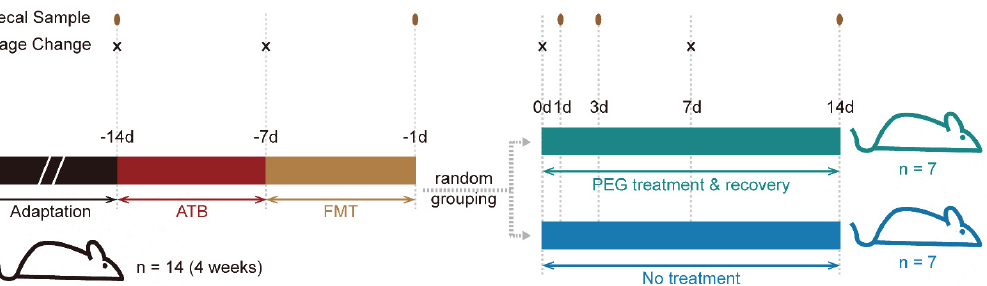
Figure 2. Schematic of animal experimental design and collection protocol. The adaptation period of mice is one week; ATB, gavage with antibiotics; FMT, fecal microbiota transplantation from healthy donor to mice; PEG treatment, gavage polyethylene glycol electrolyte solution for bowel cleansing. The times of fecal sample and cage change have been marked in the